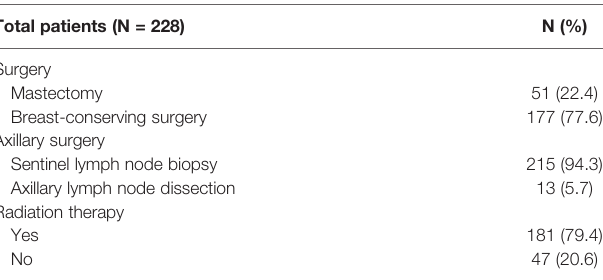
TABLE 2 | Type of surgery and adjuvant treatment.